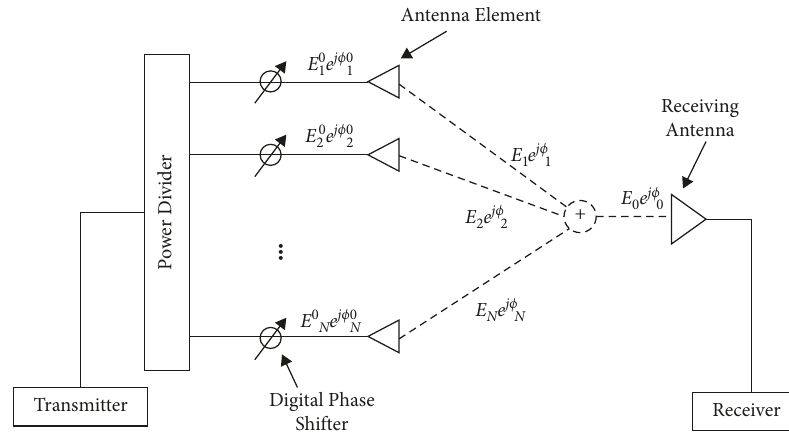
Figure 1: Far-field setup and signal model of the power-only calibration method.